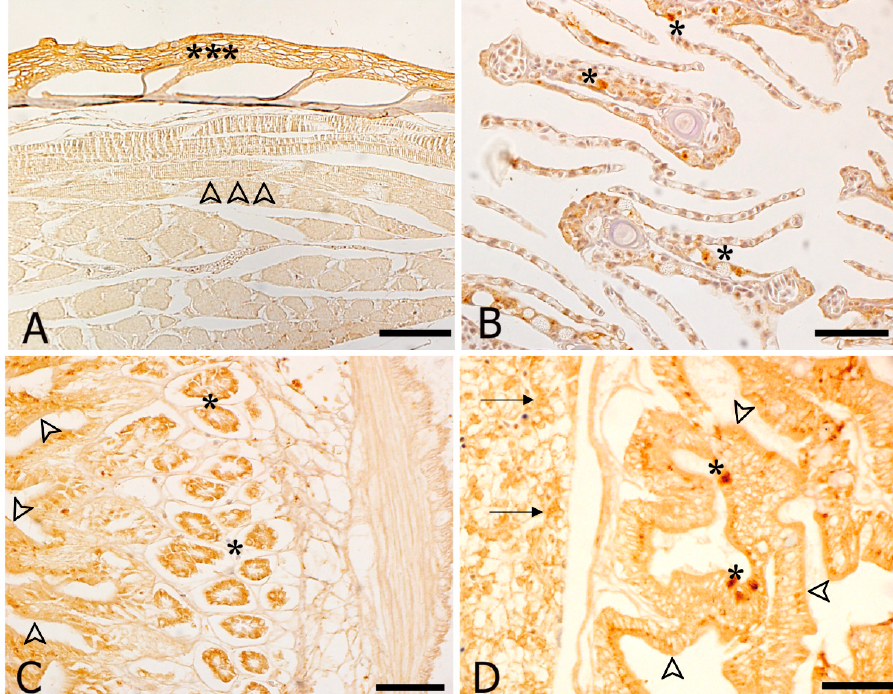
Figure 5. Immunohistochemical localization of IGF-I in Sparus aurata . All panels are counterstained with haematoxylin. ( A ) control fish. In the skin, immunopositivity was localized at the level of the epithelium (asterisks), whereas the trunk musculature is negative (arrowheads); ( B ) thermal stressed fish. In gills, the epithelium of primary and secondary lamellae showed an immunoreactivity (asterisks); ( C ) salinity stressed fish . The epithelium of the stomach shows immunoreactivity to IGF-I antibody (arrowheads); a positivity was also evident in the gastric pits (asterisks); ( D ) ammonia stressed fish. Enterocytes (arrowheads), intestine rodlet cells (asterisks) and liver parenchyma (arrows) showing strong immunoreactivity to IGF-I antibody. Bars: 40 μ m ( A ), 200 μ m (B), 200 μ m ( C ), 200 μ m ( D ).